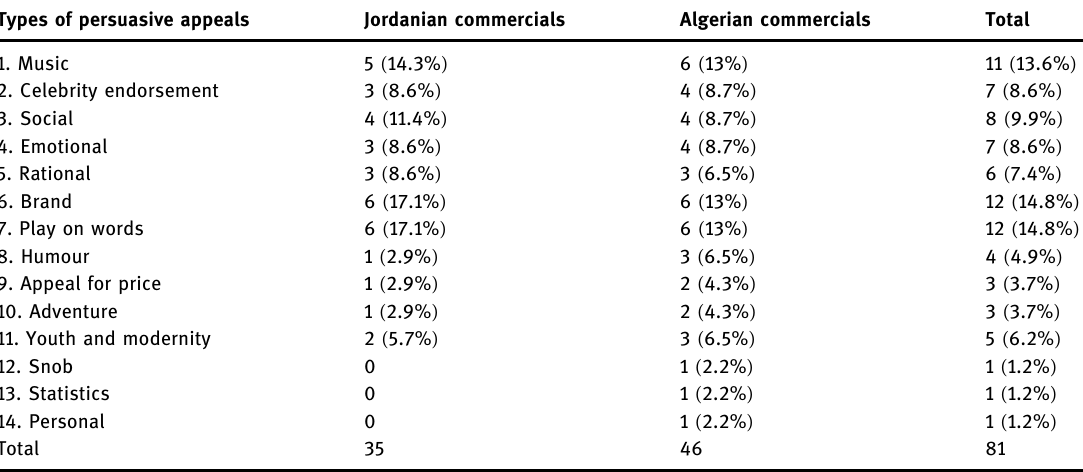
Table 2: Frequencies and percentages of the persuasive appeals used in the two samples Types of persuasive